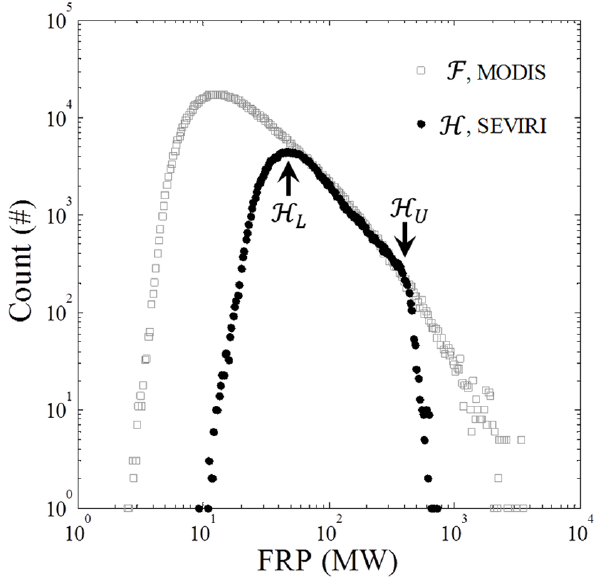
Figure 14. Cumulative FRP (MW) in a scene as measured by Meteosat-8 operating in special operations mode across the region of the rapid scan observations (3 ◦ N–33 ◦ S) when data were deliv- ered using different geometric resampling schemes (nearest neigh- bour and bi-cubic convolution) and image processing filters (stan- dard sinc function shown in Fig. 7 and top hat, which equates to no significant digital filtering). Data were collected between 3 and 7 September 2007.